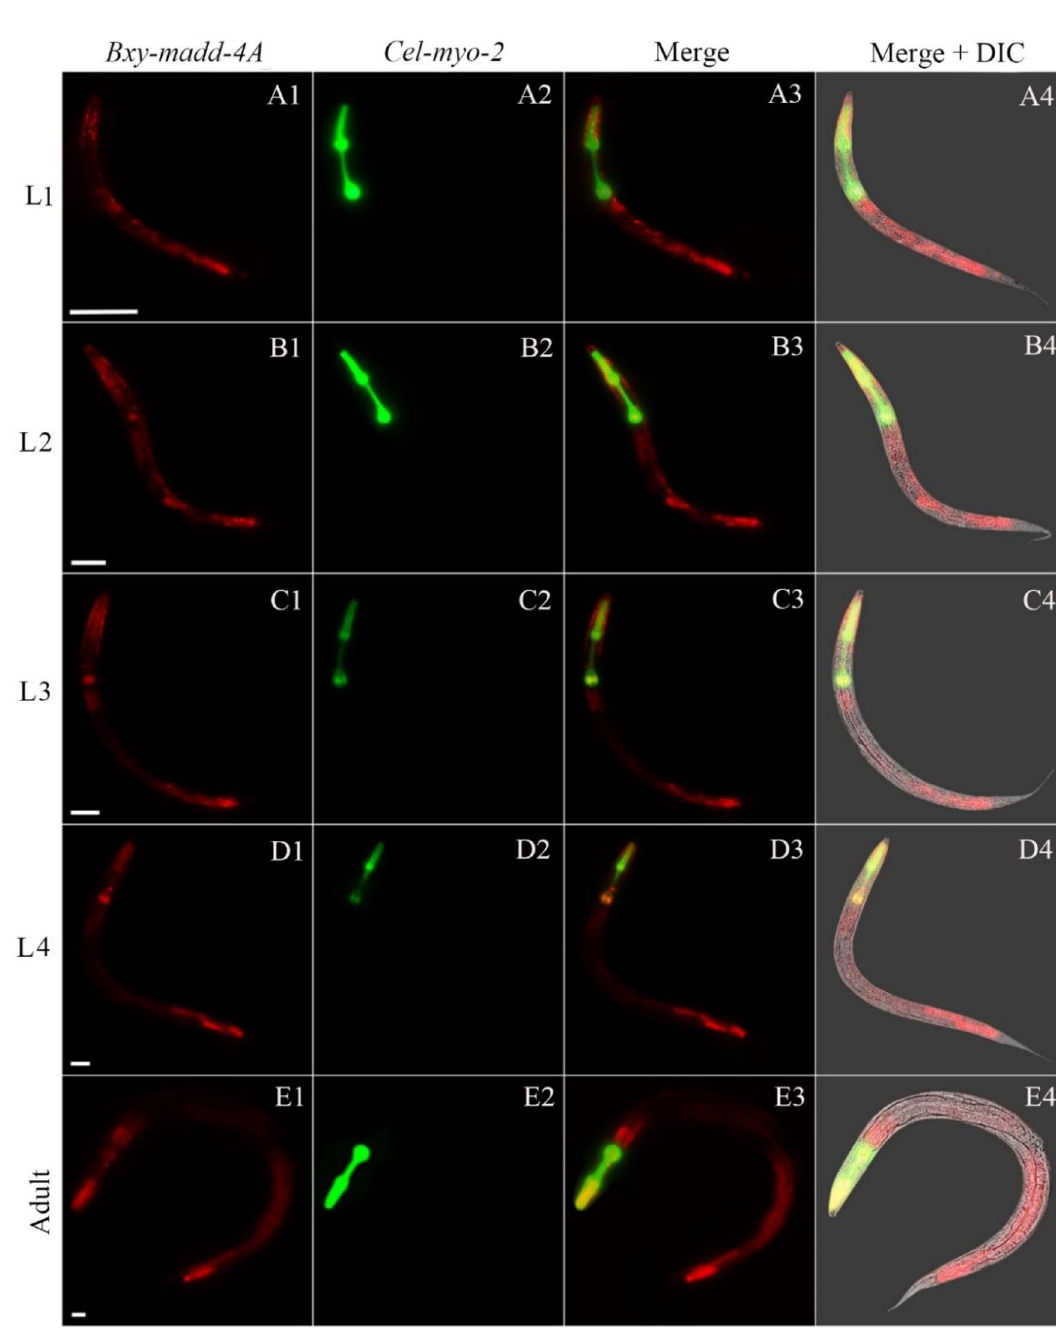
Figure 5. Localization of Bxy-madd-4A on translational level via transgenic C. elegans during postembryonic development. The expression patterns of mCherry (red) under control of B. xylophilus madd-4A promoter and green fluorescent protein gene (green) was driven by C. elegans promoter myo-2 as a marker for pharynx development. Fluorescent and differential interference contrast (DIC)merged microscope images of the second filial generation transgenic C. elegans carrying both Bxy-madd-4Ap ::mCherry and Pmyo-2 ::GFP transgenes. L1, first-stage juvenile (A1–A4); L2, second-stage juvenile (B1–B4); L3, third-stage juvenile (C1–C4); L4, fourth- stage juvenile (D1–D4); and adult hermaphrodite (E1–E4). In each age group, 50 nematodes were examined. The scale bar stands for 20